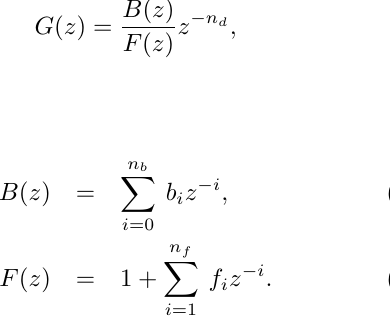
Figure 9: The eight successful process models. ’P1’, ’P2’, and ’P3’ refer to the number of poles (one, two, or three). ’D’ means that time delay is estimated. ’Z’ means that a zero is estimated. ’U’ means that two poles are un- derdamped (complex